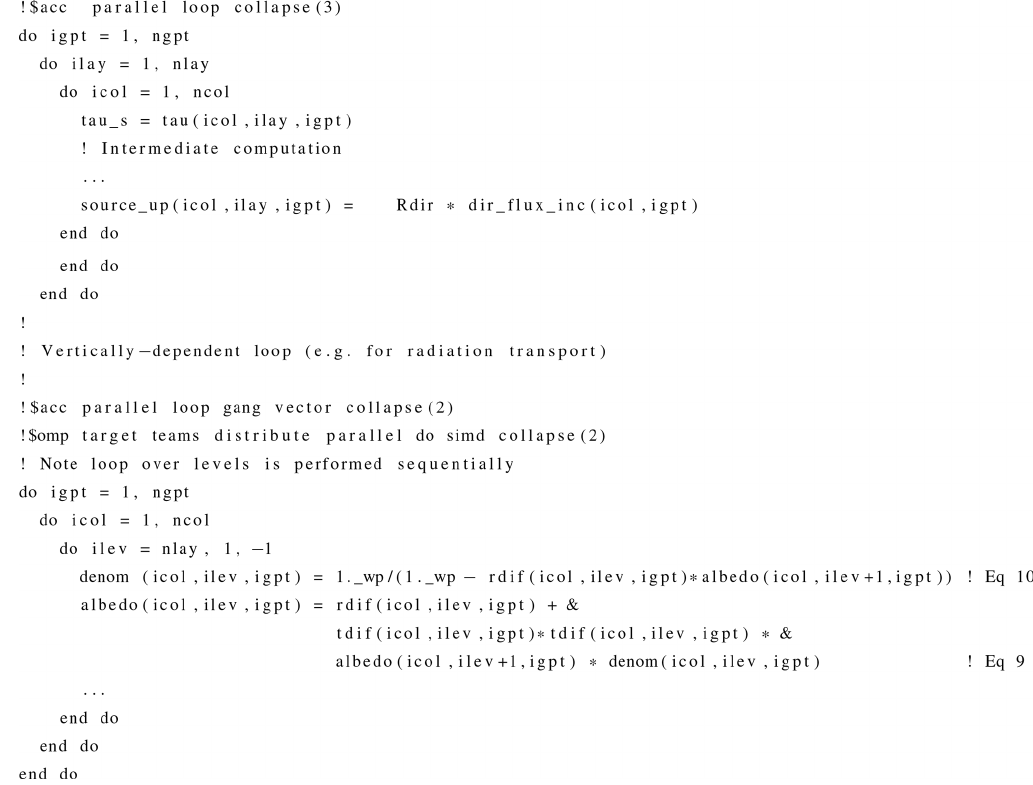
points at once, expect where dependencies in the vertical require the vertical loop to be done